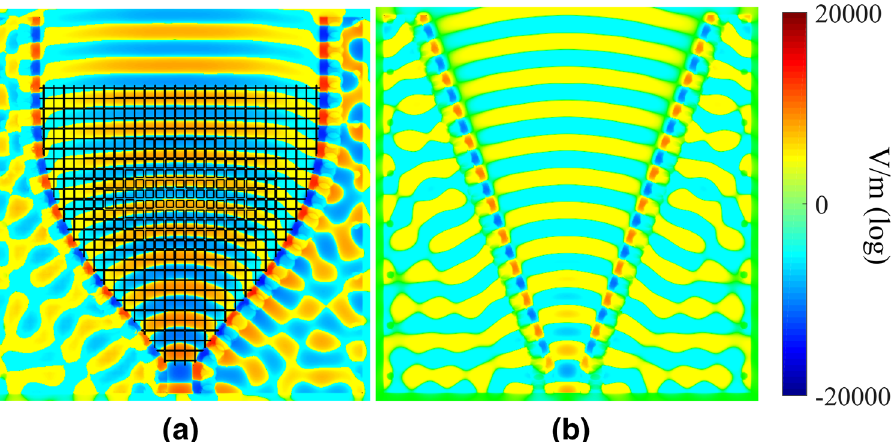
Figure 7. Simulated amplitude distribution of E z for the two H-plane antennas: ( a ) horn lens, and ( b ) reference horn. The dimensions are L L = L H = 207 mm, W L = W H = 167 mm, H L = H H = 20 mm, and F L = 40 mm.